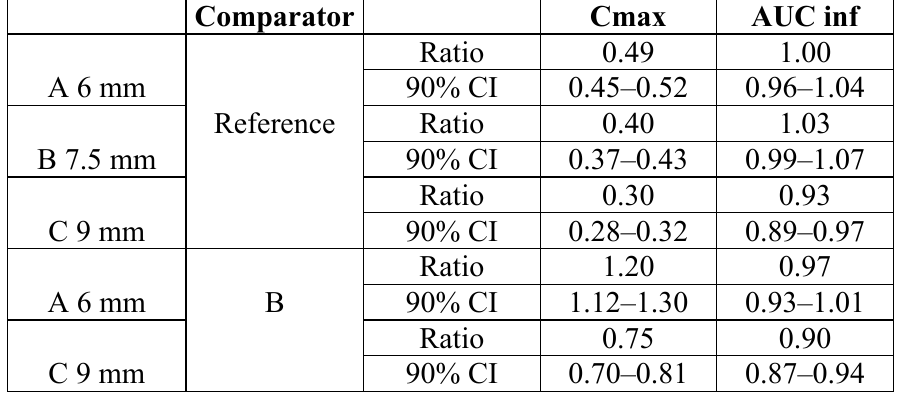
Table 2. Result of bioequivalence study (corrected by the